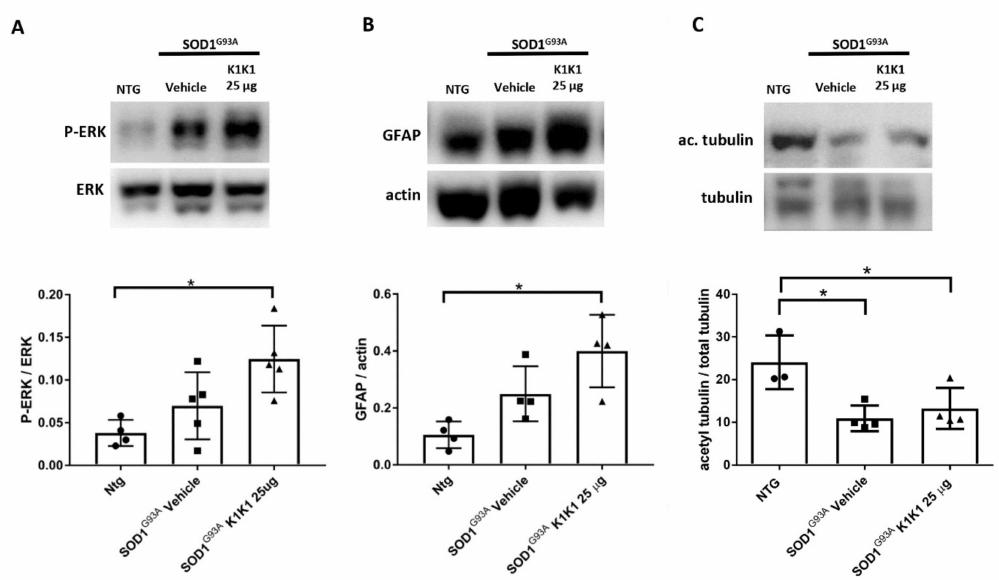
Figure 4. Treatment with 25 µ g K1K1 increased ERK phosphorylation and Glia Acid Fibrillary Protein (GFAP) expression in the sciatic nerve of SOD1G93A mice. ( A ) p-ERK levels were mildly higher in SOD1G93A mice treated with vehicle compared to NTG mice and treatment with 25 µ g K1K1 significantly increased the phosphorylation of ERK in SOD1G93A mice. A similar e ff ect was observed for the levels of GFAP ( B ). The levels of acetyl-tubulin ( C ) were significantly reduced in SOD1G93A mice, an e ff ect not modified by the K1K1 treatment. Bar graphs represents mean ± SEM ( n = 4–5). All data were statistically analyzed using One Way ANOVA followed by post hoc Fisher’s least significant di ff erence (LSD). * p <